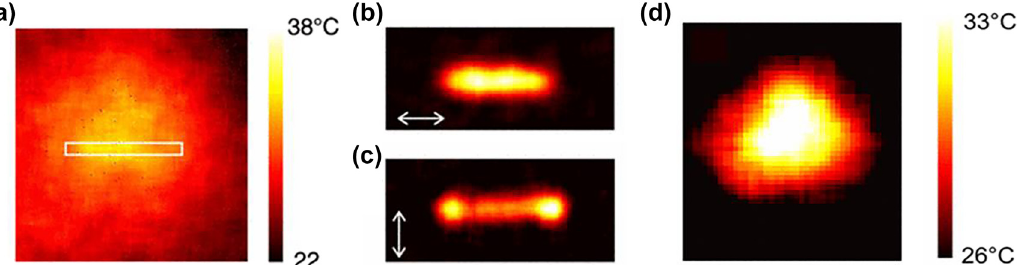
Figure 1: Temperature profile around plasmonic